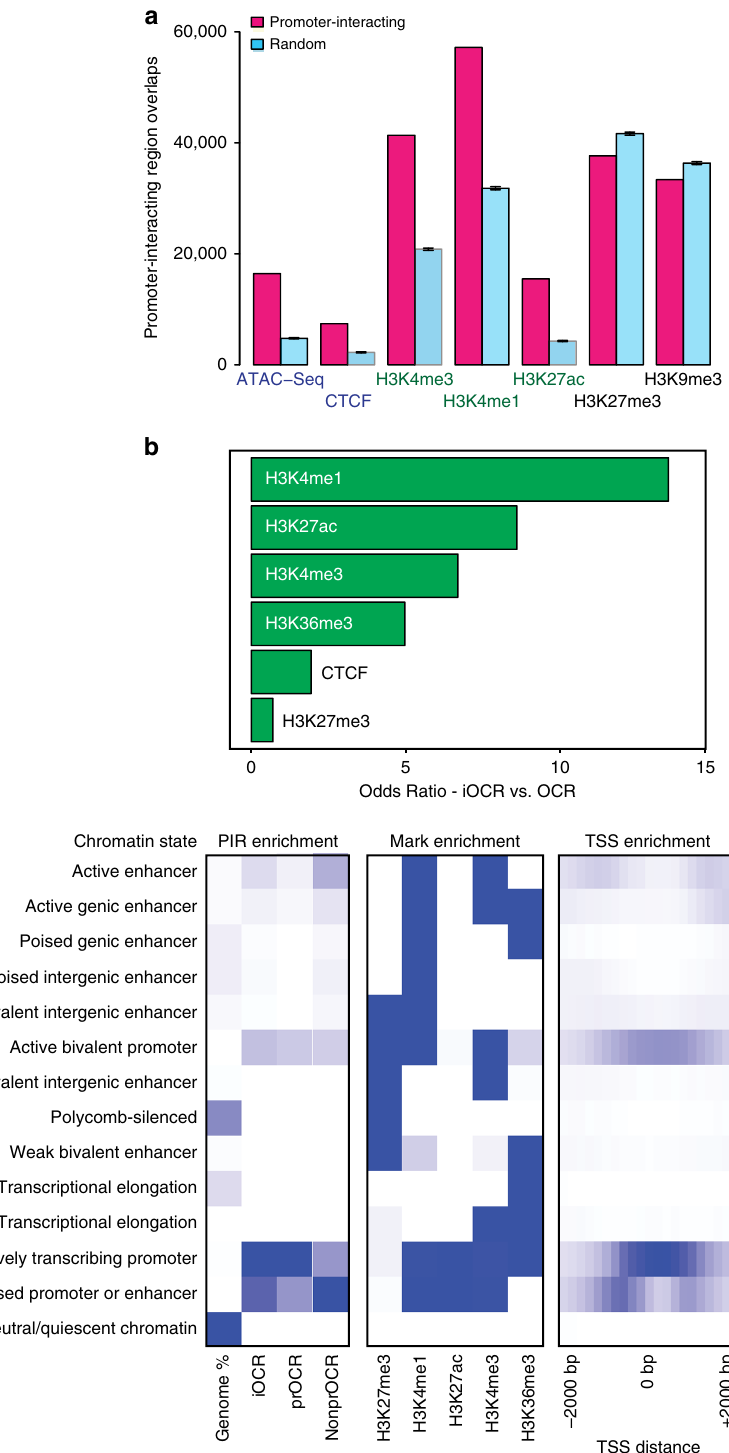
Fig. 4 Enrichment of chromatin signatures at promoter-interacting regions. a PIR enrichment for genomic features compared with distance-matched random regions in naive T cells using CHiCAGO. Mean± 95% CI is depicted across 100 draws of non-signi fi cant interactions. b Feature enrichment at promoter-interacting OCR (iOCR) compared to a random sample of non-promoter-interacting OCR in naive T cells. c Enrichment of iOCR within chromHMM-de fi ned chromatin states and TSS neighborhood in naive T cells. Fourteen ChromHMM state models based on 5 histone modi fi cations (H3K4me1, H3K4me3, H3K27me3, H3K27ac, and H3K36me3) are shown in the middle panel, with blue color intensity representing the probability of observing the mark in each state. The heatmap to the left of the emission parameters displays the overlap fold enrichment for iOCR in promoters (prOCR) and non-promoter iOCR (nonprOCR), while the heatmap to the right shows the fold enrichment for each state within 2 kb around a set of TSS. Blue color intensity represents fold